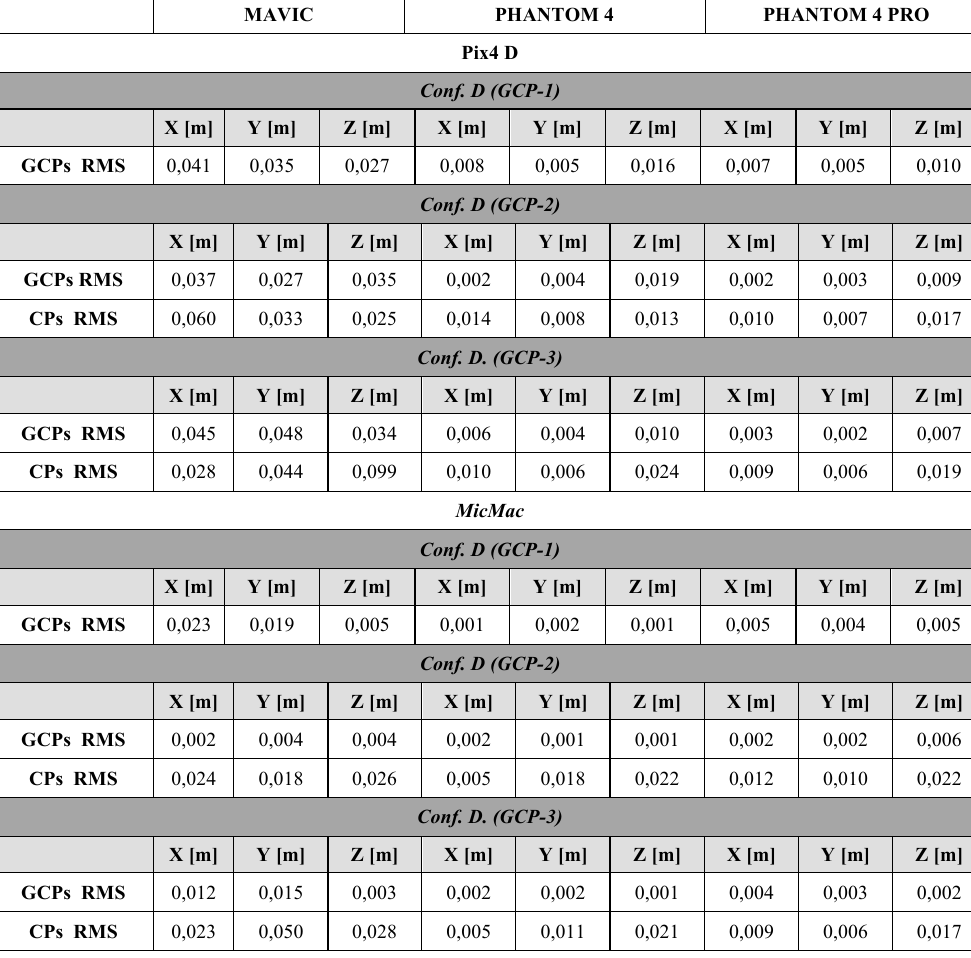
Table 5 Achieved RMS with Pix4D and MicMac according to flight Configuration